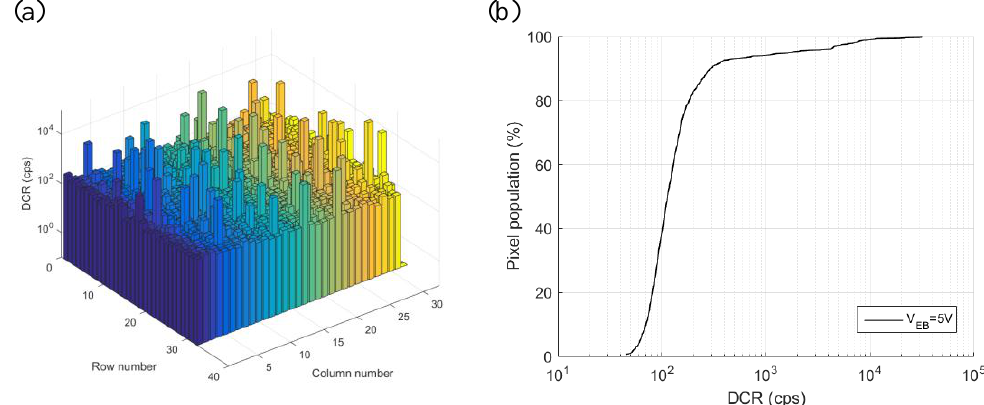
Figure 9. ( a ) DCR map and ( b ) DCR cumulative proportion of the whole array with 5 V excess bias voltage at 20 °C.